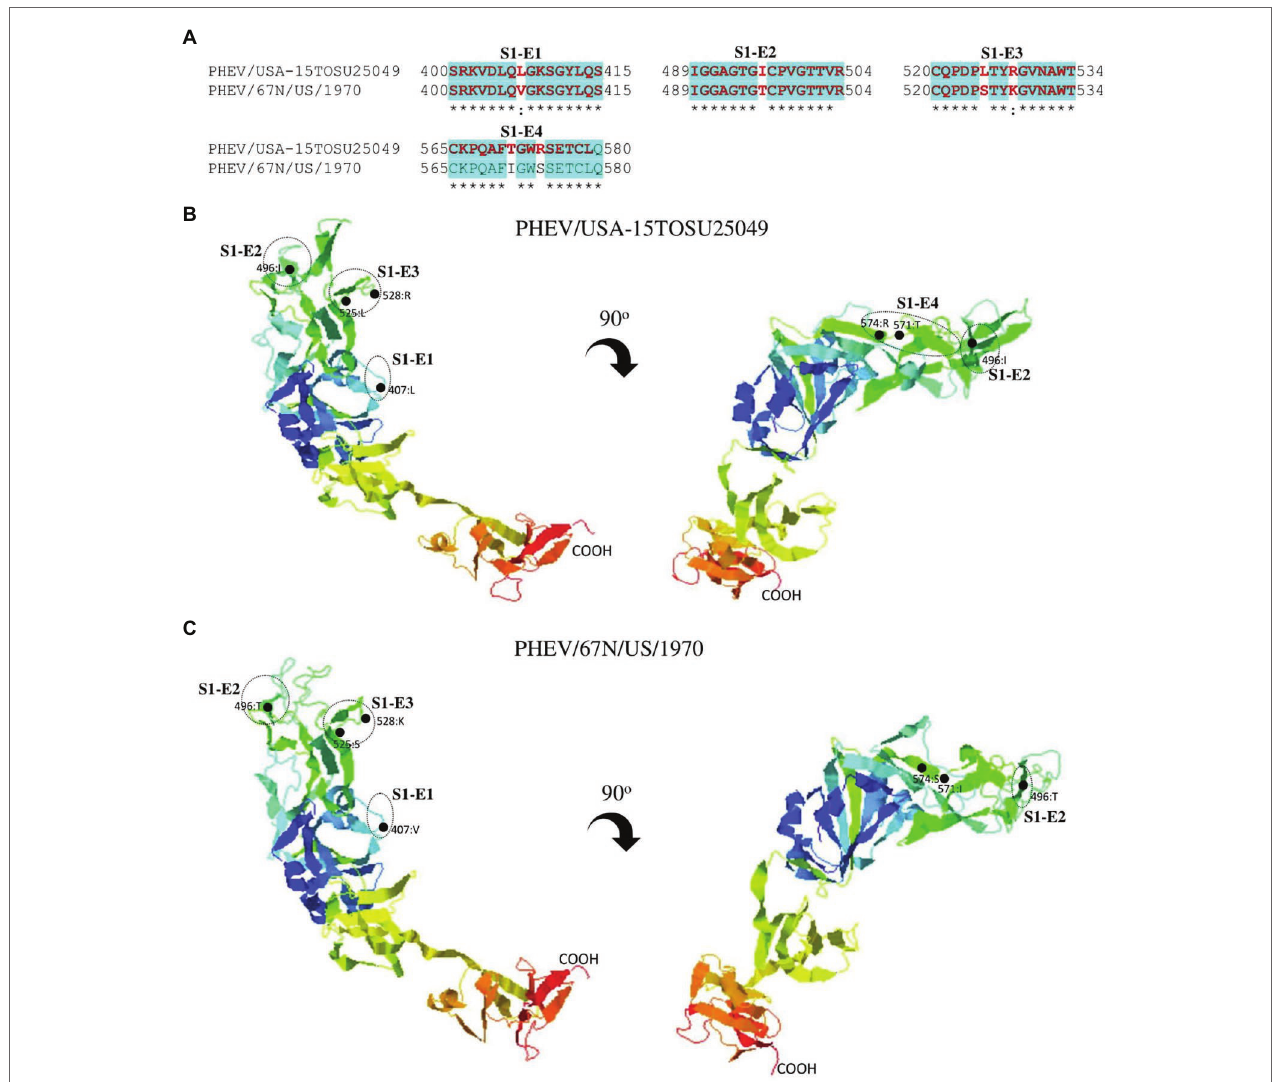
FIGURE 7 | Comparison of linear B cell epitopes affected by amino acid variations in the S1-RBD between PHEV/USA-15TOSU25049 and PHEV/67 N/US/1970. (A) Amino acids of the predicted linear B cell epitope are indicated with bold red letters, while numbers refer to their positions relative to the corresponding full-length S glycoprotein. Three-dimensional view of epitopes in the S1-RBD of PHEV/USA-15TOSU25049 (B) or PHEV/67 N/US/1970 (C) . The predicted epitopes are circled, and amino acid variations are marked with black